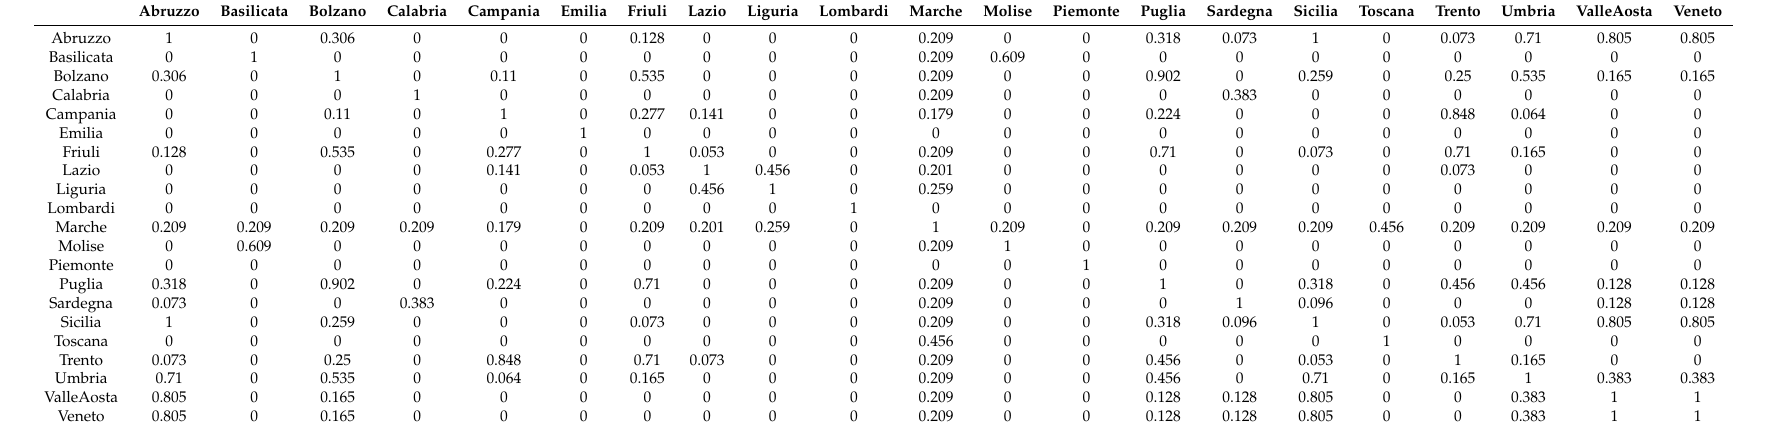
Table A29. Similarity values of Total Currently Positive network in the fourth week.